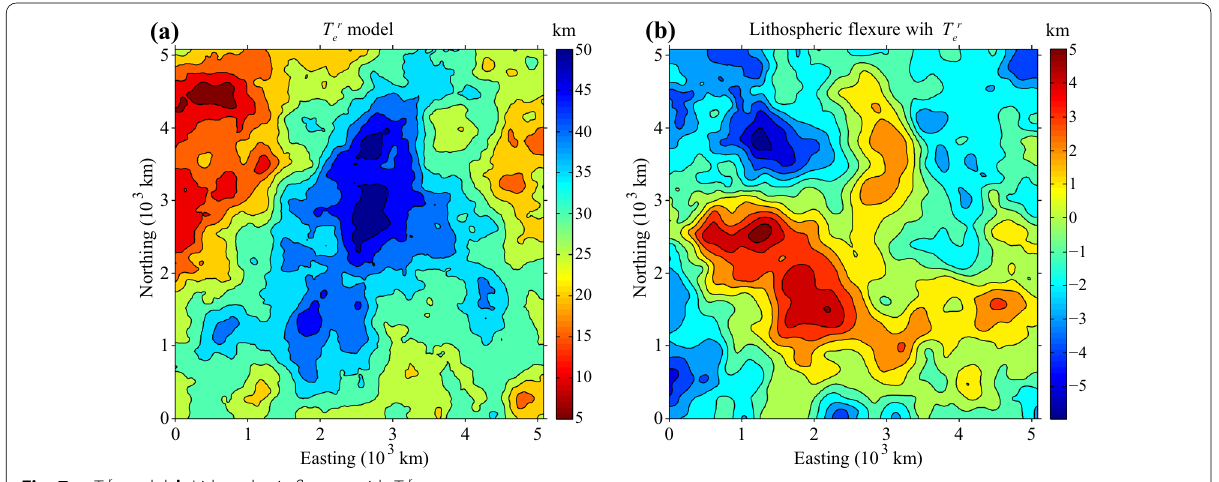
Fig. 7 a T er model. b Lithospheric flexure with T er